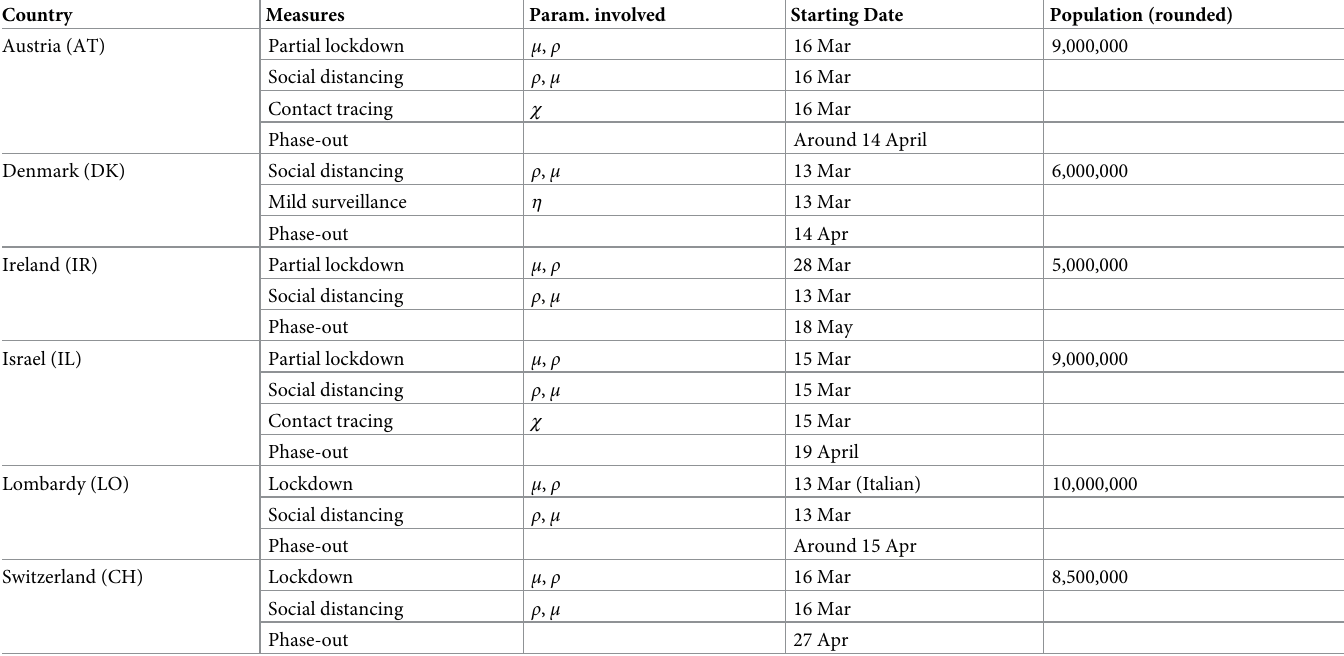
Table 1. Test countries, with measures